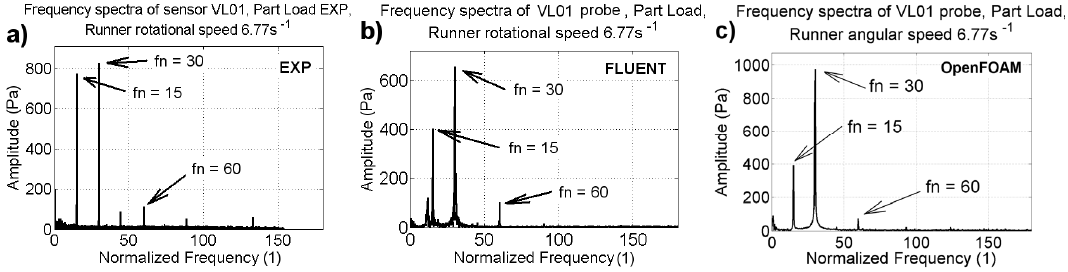
Figure 17. Comparison of pressure amplitudes and frequencies in the vaneless space (VL01) under part load operating conditions; the dimensionless frequency of 30 corresponds to the blade passing frequency [20]. ( a ) Power spectra at the location VL01obtained using experimental pressure values ( b ) Power spectra at the location VL01 obtained using FLUENT solver ( c ) Power spectra at the location VL01 obtained using OpenFOAM solver.